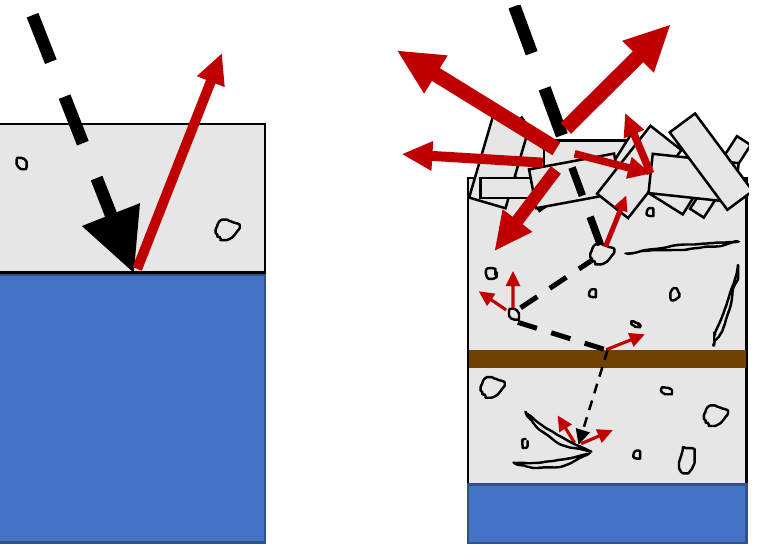
Figure 1. Schematic diagram of microwave interactions with physical properties of river ice. Black dashed arrows represent incident microwaves and red solid arrows represent scattered radiation. In smooth, relatively thin ice with few impurities, incident microwave radiation can penetrate the ice cover and almost all scattering is due to the dielectric change at the ice-water interface. A more complex ice cover contains more scattering mechanisms and results in higher amounts of backscattered